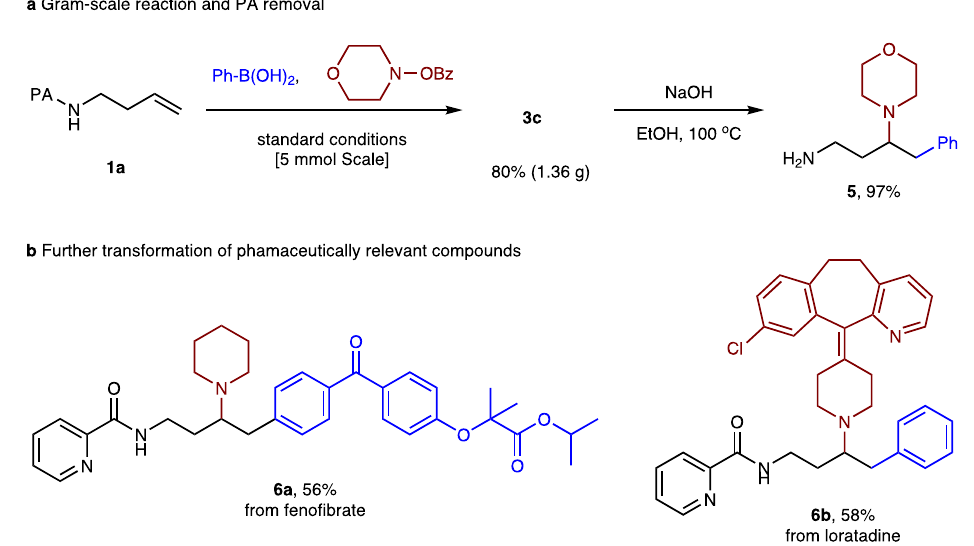
Fig. 6 Synthetic potential. a Gram-scale reaction and PA removal. b Further transformation of phamaceutically relevant compounds.